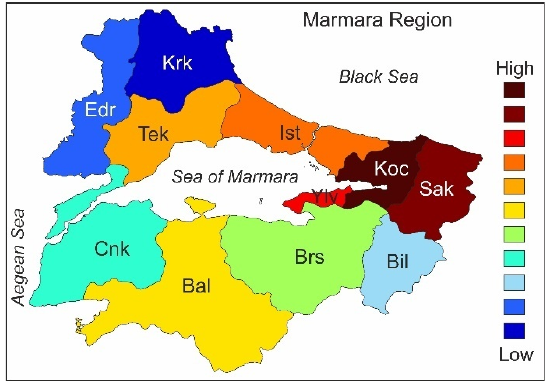
Figure 14. Risk status of studied provinces obtained from the parameters.